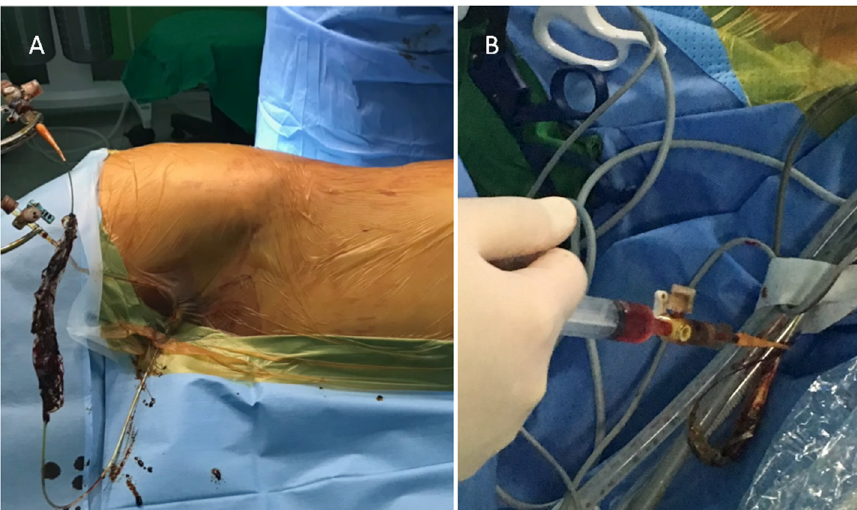
Figure 2 . Administration of fluorophore via microcatheter. ( A ) The microcatheter was fixed with